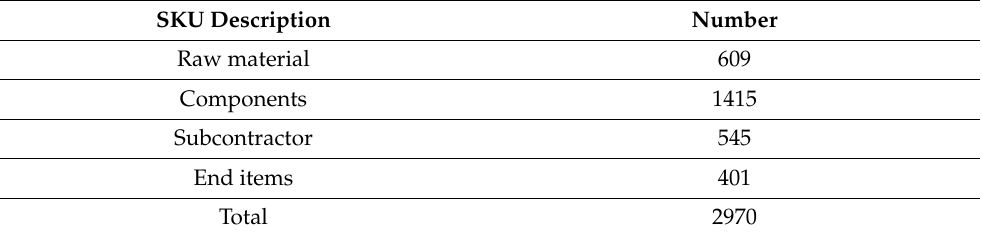
Table 1. Total number of SKUs.